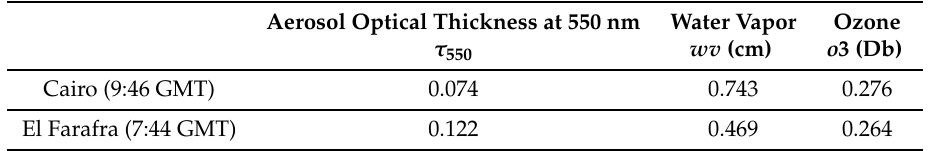
Table 2. Direct products of the AERONET stations in Cairo and El Farafra closest in time to the OLI image considered in this study (6 December